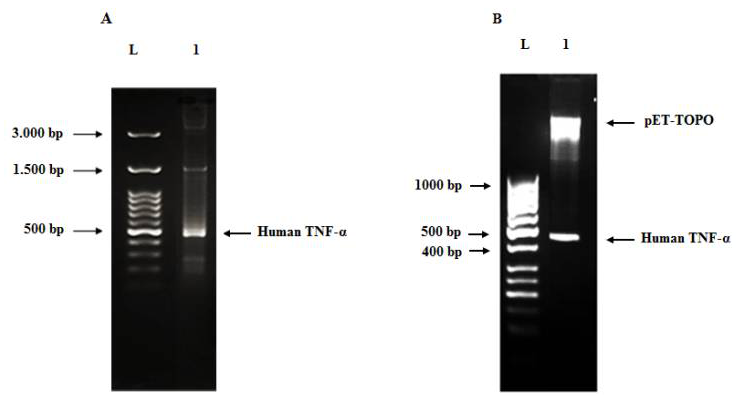
Figure 6. Agarose gel (2%) of human TNF-α PCR product from recombinant plasmid ( A ), agarose gel (1.2%) of restriction digestion of pET101/D-TOPO-human TNF-α plasmid using BamH I and Xho I enzymes at 37 °C for 1 h ( B ). Lane L: DNA ladder, lane 1 ( A ): human TNF-α amplicon (490 bp) amplified from the pET101/D-TOPO-human TNF-α recombinant plasmid and lane 1 ( B ): pET101/D-TOPO vector fragment (5.763 bp) and human TNF-α insert band (480 bp).